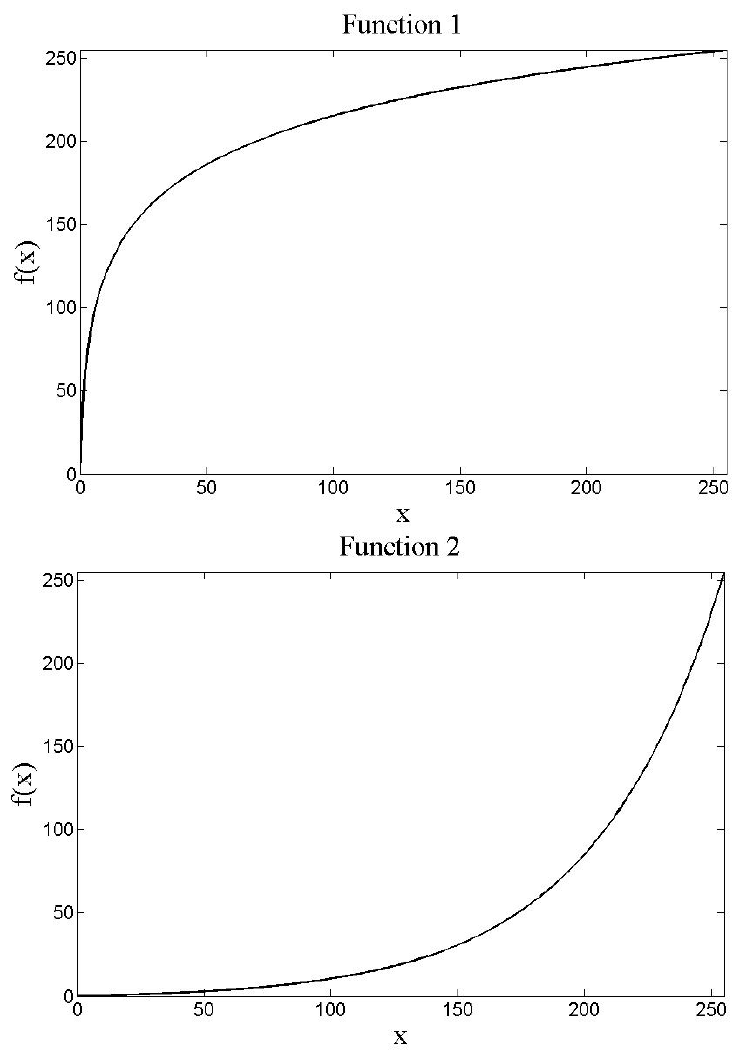
Figure 6. Four parameterized transformation functions, weighted to constitute the Genetic Transform